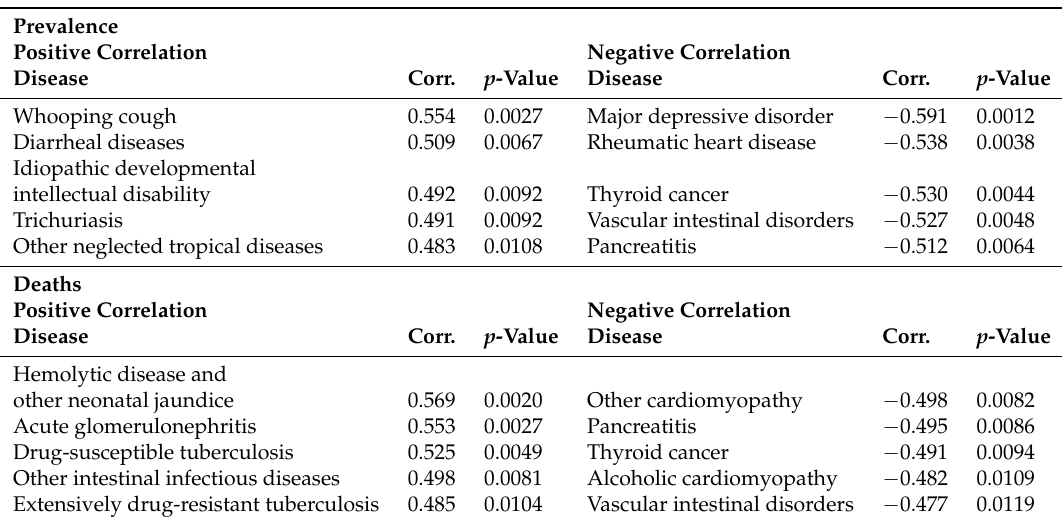
Table A1. This table shows the correlation coefficients and related p-values between prevalence or percentage of all deaths and the proportion of slum dwellers of the total population.